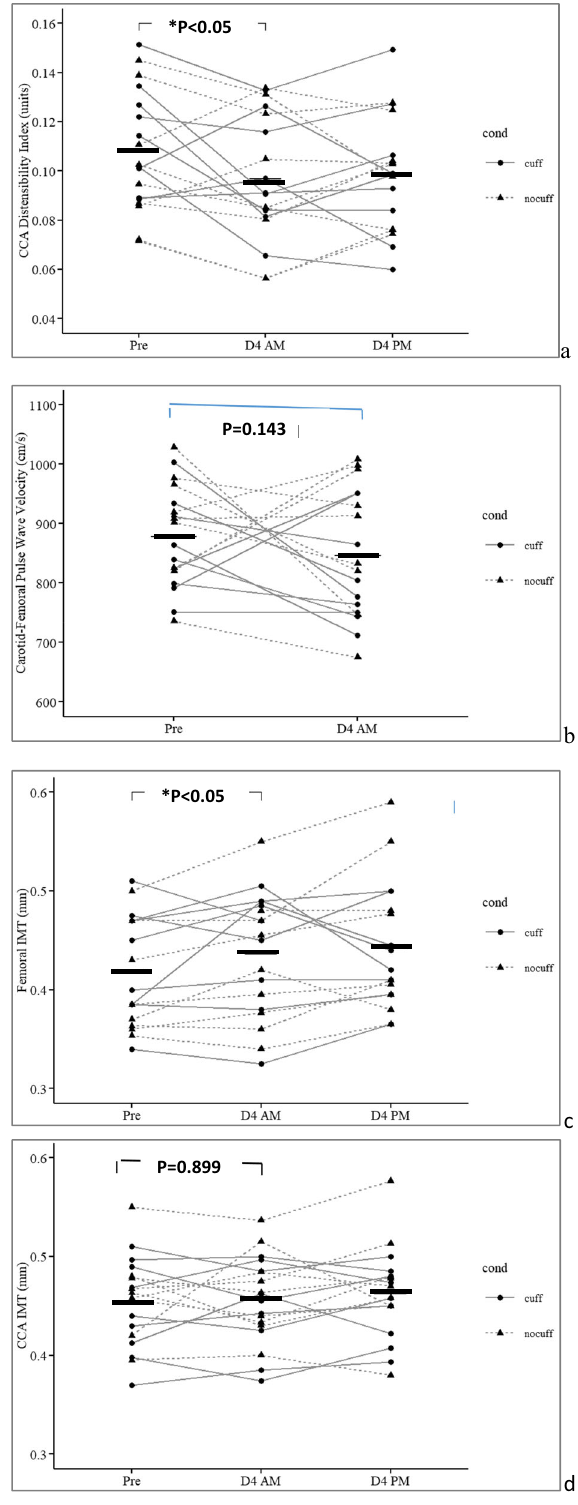
Fig. 3 Cerebral, carotid, and femoral fl ow velocity after 4 days of dry immersion. Horizontal black bars represent the mean. DI effect from Pre to D4 AM on the 2 gr averaged (* p ) is reported as “ * p < 0.0 x ” and plotted on top of the diagram. The change from D4 AM to D4 PM (with or without cuffs) are not signi fi cant for any parameter ( p not reported). Pre was prior to dry immersion; D4 AM represents 4 days of dry immersion (morning prior to donning cuffs for the day for the cuff gr). D4 PM represent the data in the afternoon of day 4, after 10 h with cuff on, for the cuff